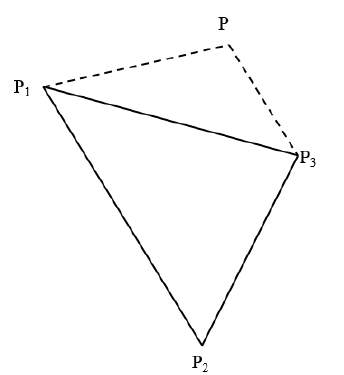
Figure 2: One edge is dead.